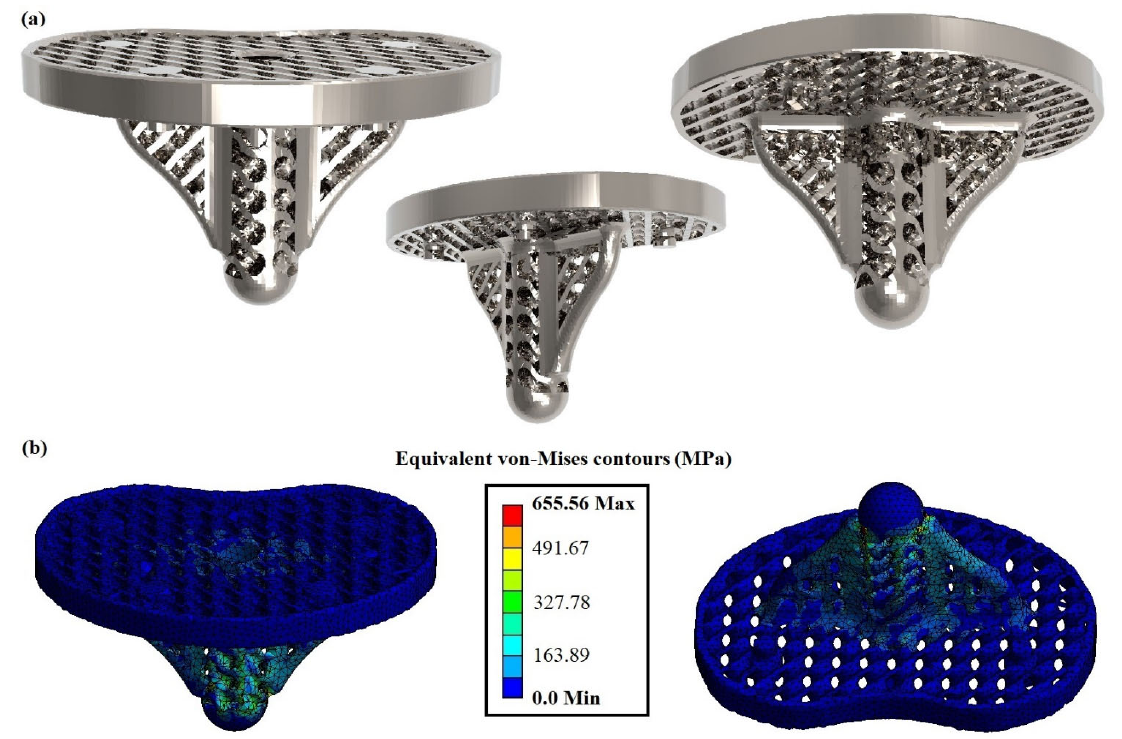
Figure 7. ( a ) Rendered images of the discrete-based topologically optimized tibial implant; ( b ) Con- tours of the discrete-based topologically optimized tibial implant for equivalent von Mises stresses.